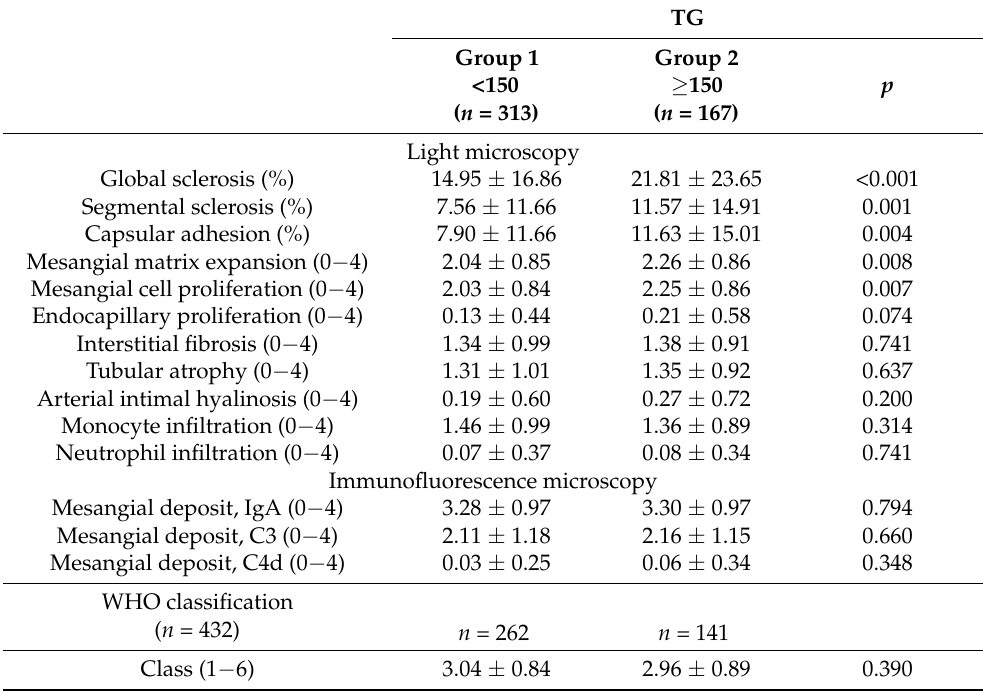
Table 5. Histopathological findings for the TG groups.